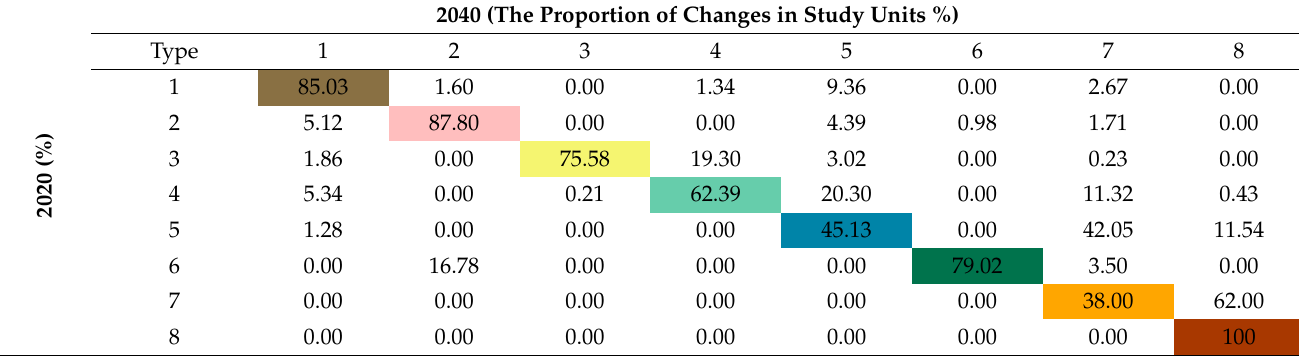
Table 7. Transfer matrix of LCTs from 2020 to